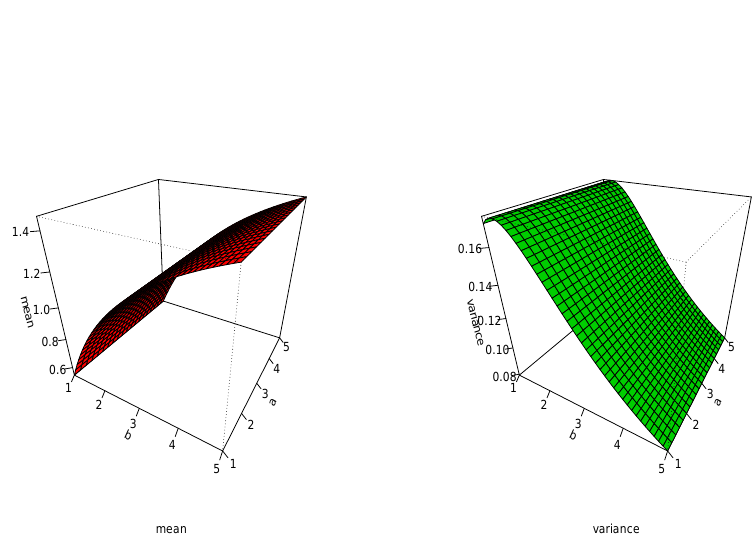
Fig. 3. Plots of the mean and variance for the TExGW distribution